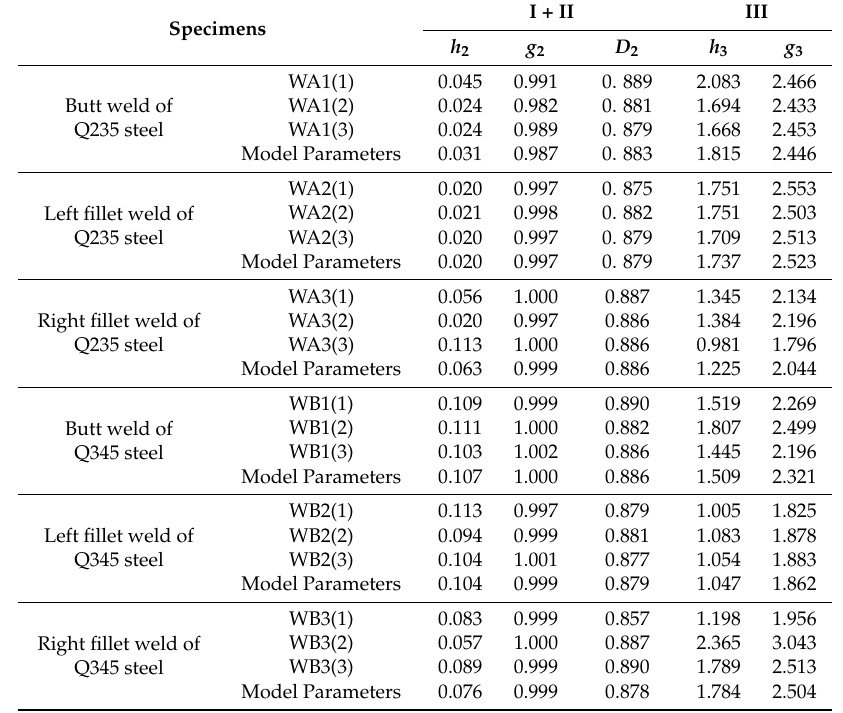
Table 8. Values of parameters g ,